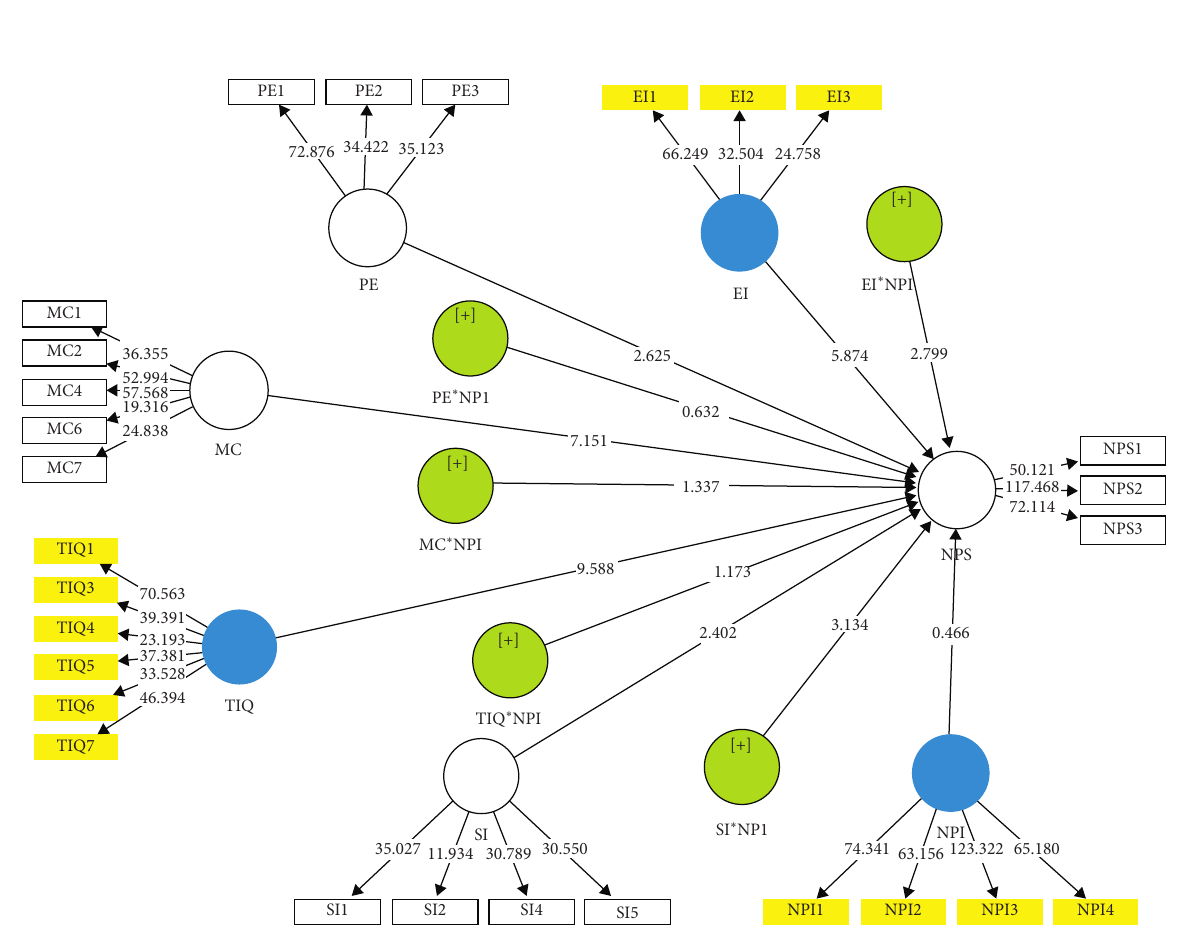
Figure 6: Structural assessment